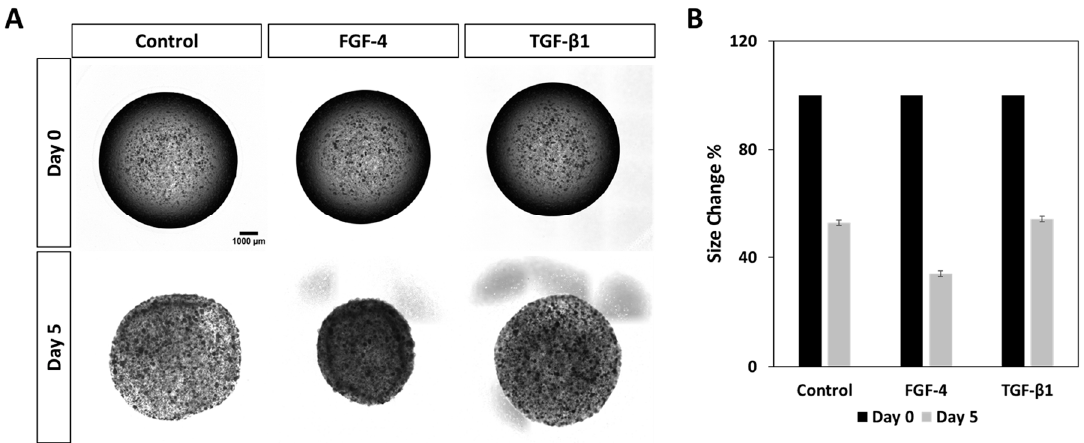
Figure 6. Effects of FGF-4 and TGF- β 1 on the shape ( A ) and size ( B ) of cardiomyocyte-containing hydrogels for 5 days. Note that the error bars were estimated by the standard deviation of two samples.